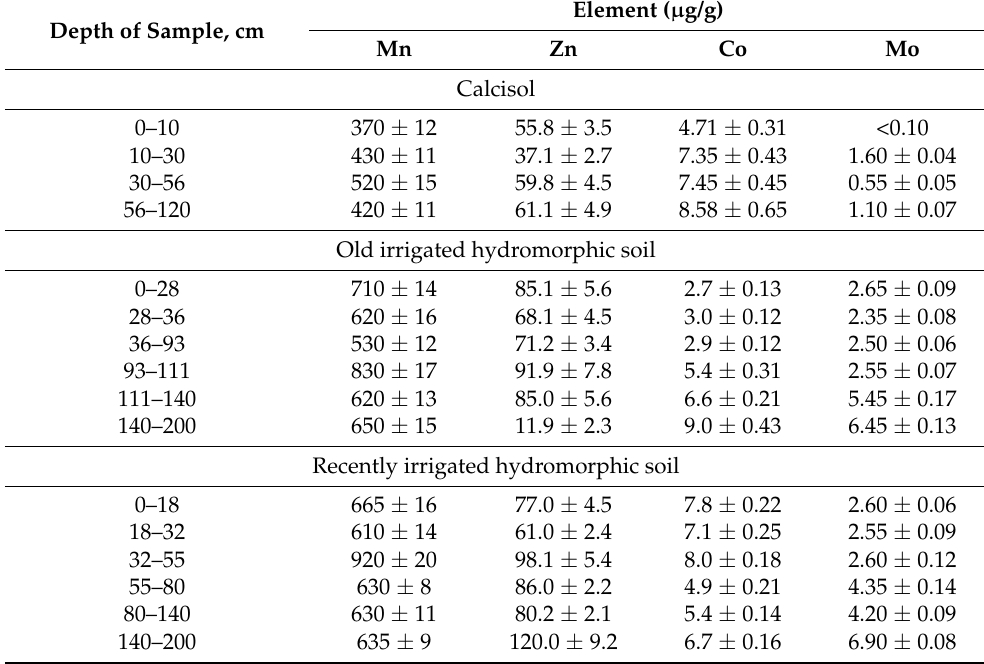
Table 4. Amount of microelements in soils ( n = 7). Depth of Sample,